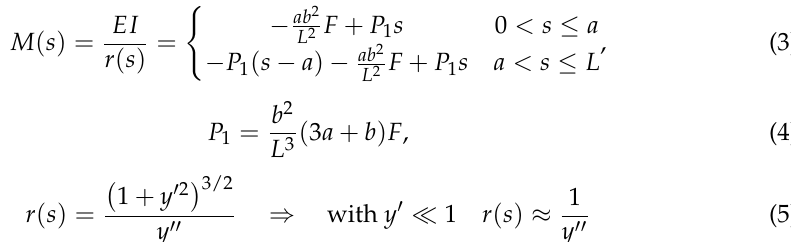
Figure 4. Simplified mechanical model of optical fibers in the proposed sensor with force F applied on it from the corresponding